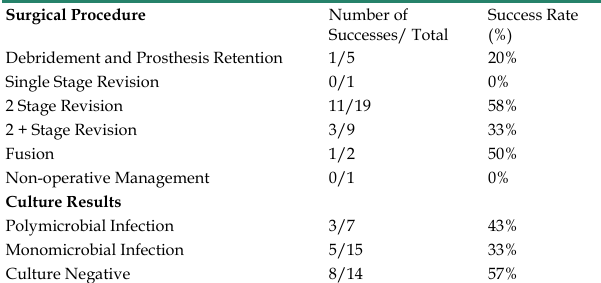
Success Rate Successes/ Total (%)